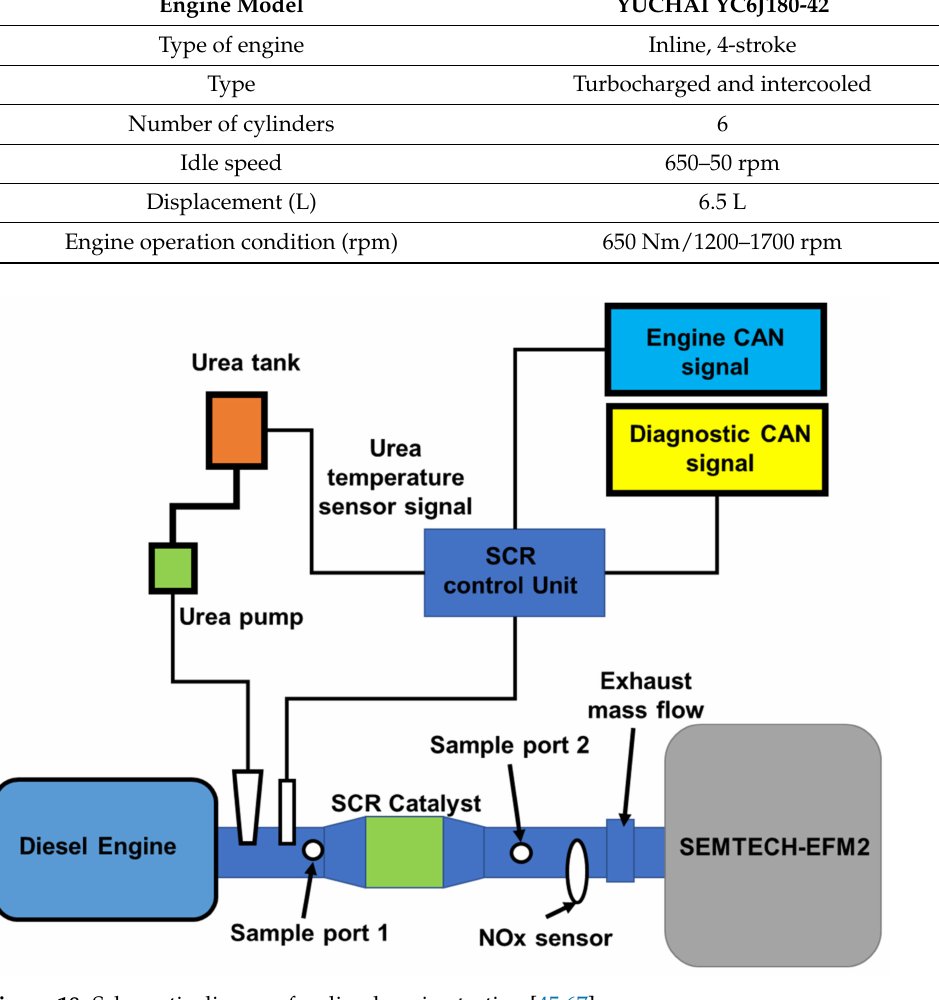
Figure 18. Schematic diagram for diesel engine testing